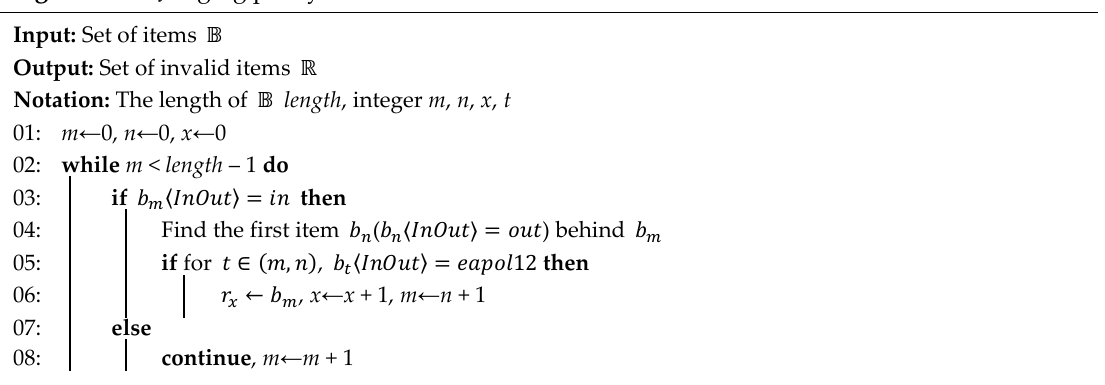
Algorithm 2: Judging policy for access validness